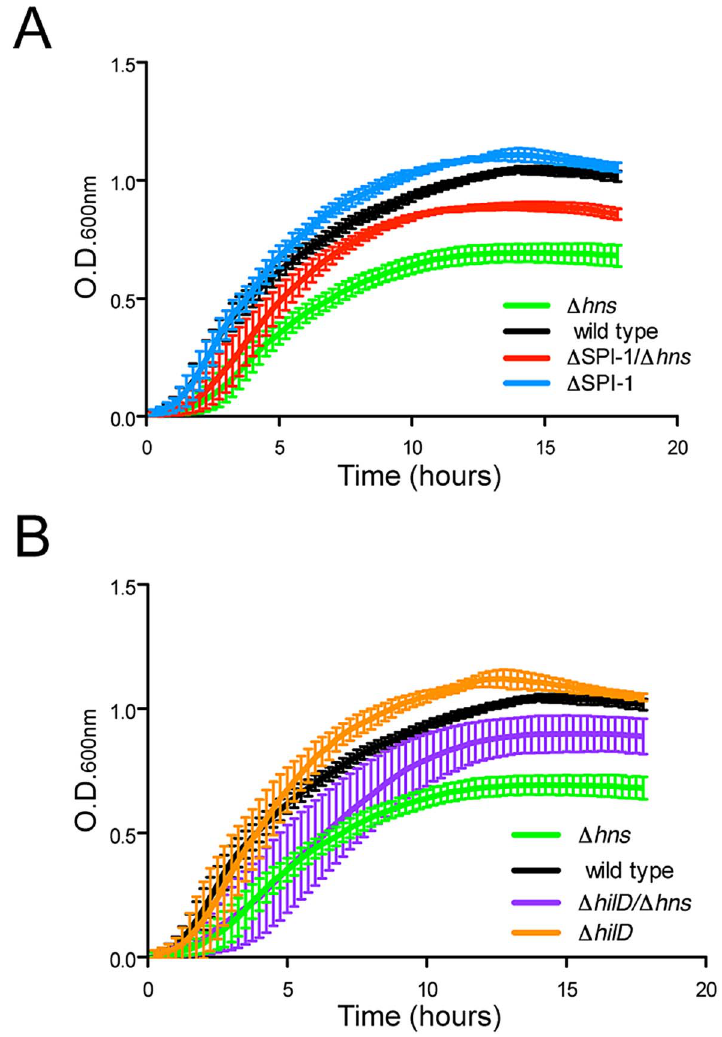
Figure 4. Disruption of SPI-1 expression improves fitness of an hns mutant. (A) Growth of a wild type S. Typhimurium (black curve) and a D hns strain (green curve) was monitored in liquid media alongside wild type and D hns strains harboring a 40 kb SPI-1 deletion (blue and red curves respectively). Elimination of the SPI-1 locus significantly increased growth of the D hns strain and also provided a slight growth advantage in the wild type background. (B) Targeted disruption of hilD , the master SPI-1 activator produces a similar growth outcome as the SPI-1 deletion. Growth curves of the D hilD and D hilD/ D hns strains are represented in orange and purple respectively. The corresponding wild type (black) and hns mutant (green) growth curves are the same as panel A. Plotted is the average of three biological replicates and standard error (panels A and